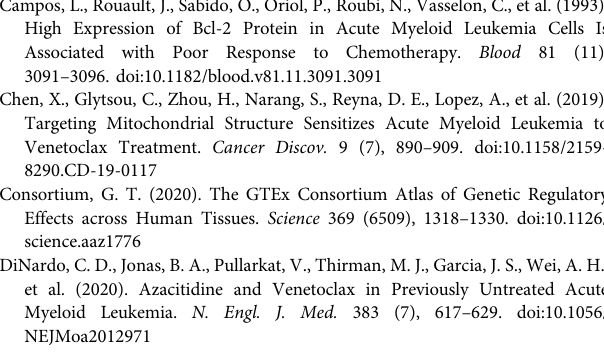
Supplementary Table S1 | Univariate and multivariate Cox regression analyses. Supplementary Table S2 | GO enrichment analysis and KEGG pathway